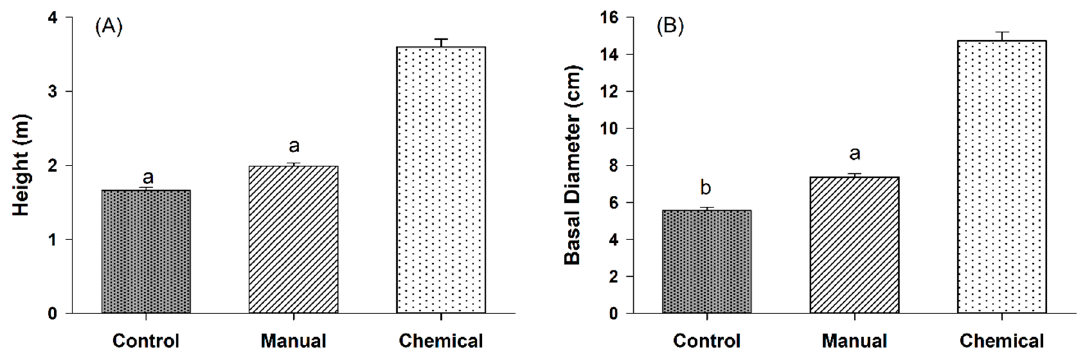
Figure 5. Means and standard errors of ( A ) height and ( B ) basal diameter for twelve-year-old ponderosa pine trees grown in no release control, manual release, and chemical release treatments. Different letters (a, b) refer to a significant difference between the two treatments ( p < 0.05). Chemical release was not included in the analysis because it was not in the original design.